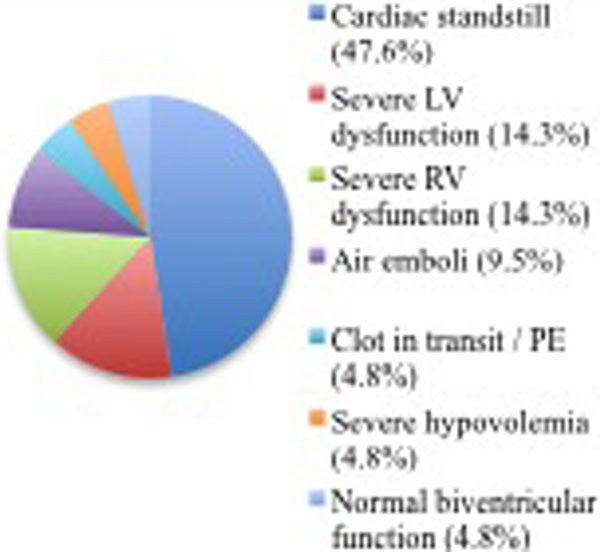
Ultrasound findings.